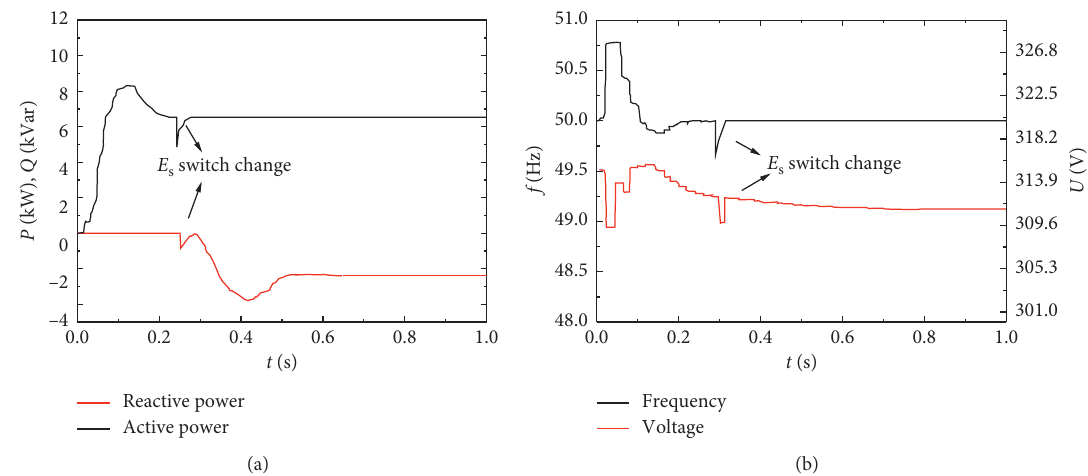
Figure 8: Power balance dynamic adjustment. (a) Active and reactive dynamic adjustment. (b) Dynamic changes in voltage and frequency.